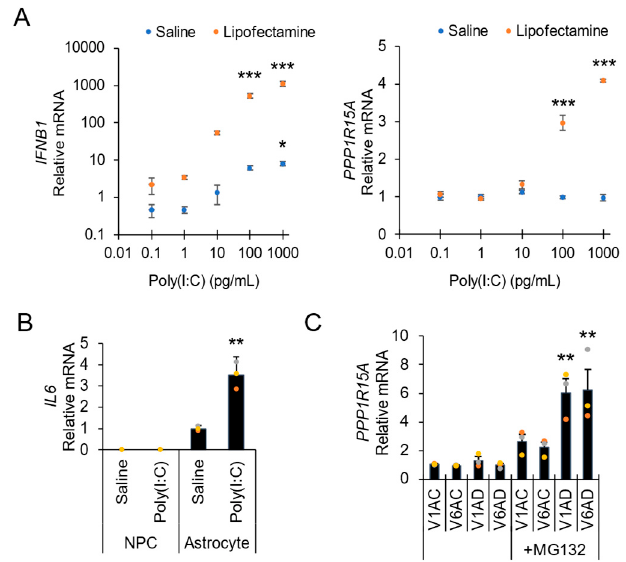
Figure 3. Example applications of rapid direct lysis one-step RT-qPCR assay. ( A ) Application to inflammation studies: dose–response poly(I:C)-induced expression of antiviral interferon ( IFNB1 ) and GADD34 ( PPP1R15A ) in human fibroblasts. ( B ) Application to cell differentiation/inflammation studies: stimulation of proinflammatory interleukin 6 ( IL6 ) by poly(I:C) in astrocytes compared to neural precursor cells (NPC). ( C ) Application to cell culture disease model: chemical stress-induced GADD34 ( PPP1R15A ) upregulation in eIF2B disease astrocyte lines (V1AD, V6AD) in comparison to non-disease control lines (V1AC, V6AC). Astrocytes were incubated with 0.1 µM MG132 for 24 h ( n = 3; error presented as the SEM; one-way ANOVA with Holm–Sidak post hoc multiple comparisons test; ** p < 0.01, *** p < 0.001).